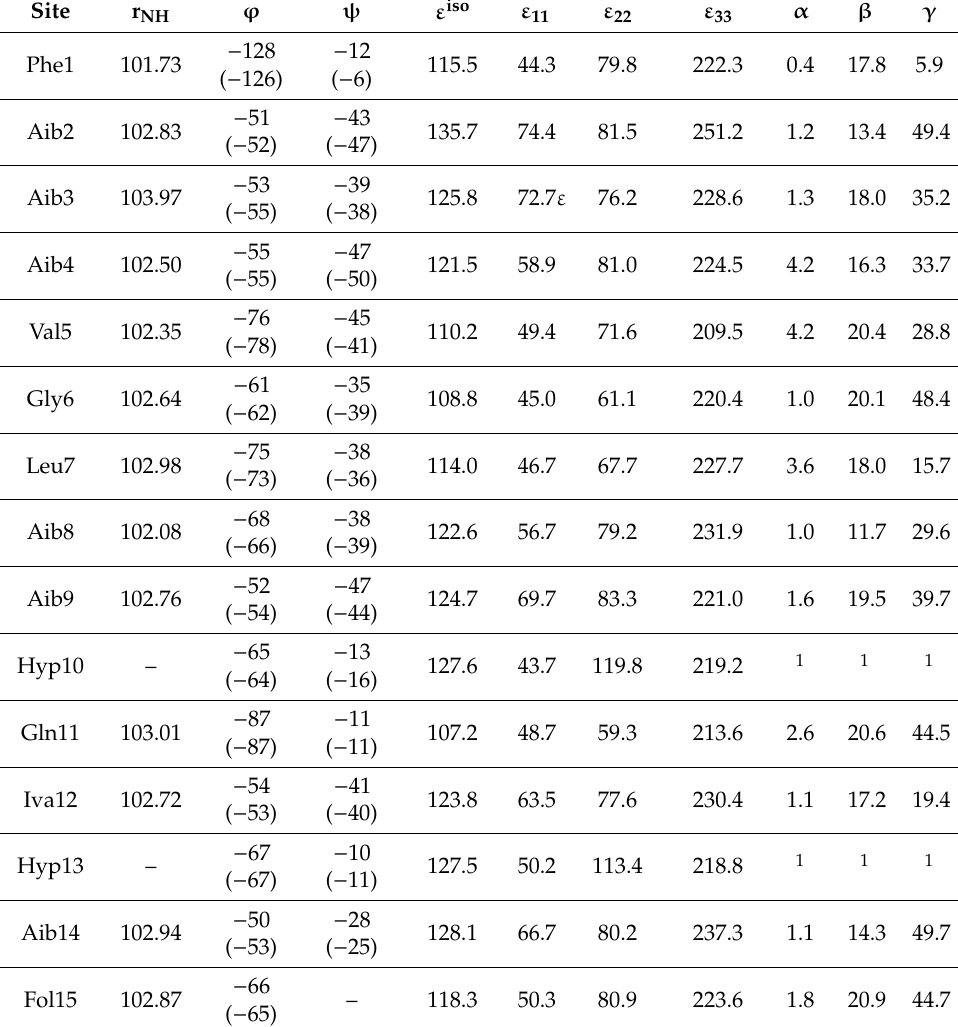
Table 4. Selected parameters of the samarosporin I backbone (values in parentheses are from the XRD study [16]). The N amid –H amid distances (r NH ) are in picometers, all angles in degrees, and { ε 11 , ε 22 , ε 33 , ε iso } data in